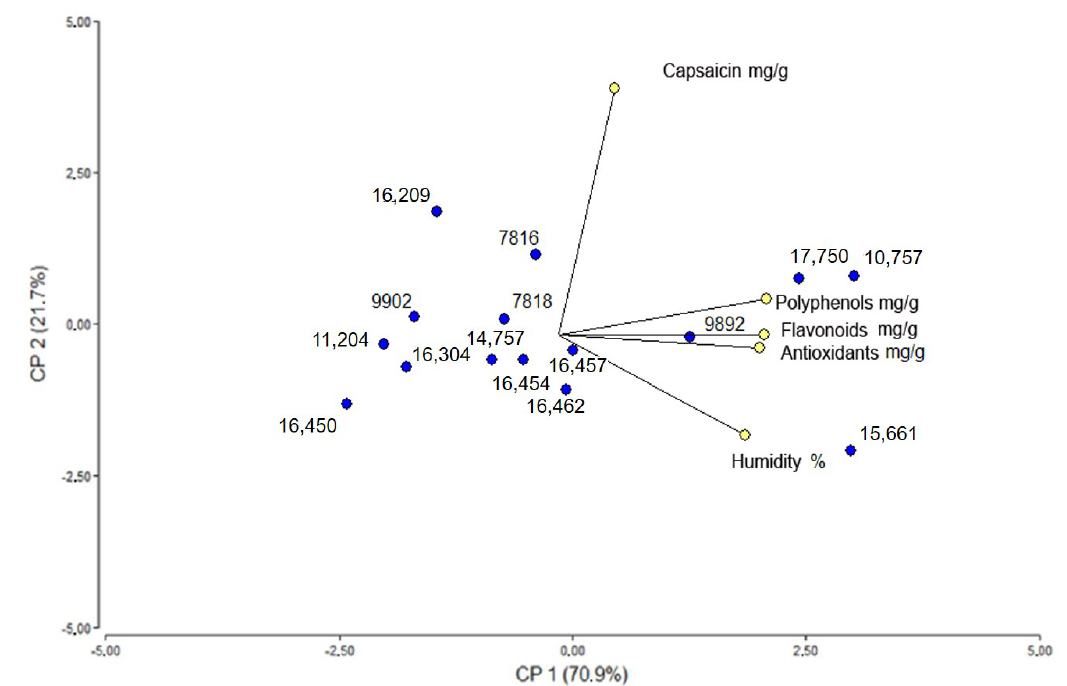
Figure 2. Biplot graph obtained from the principal component analysis of the 15 Capsicum